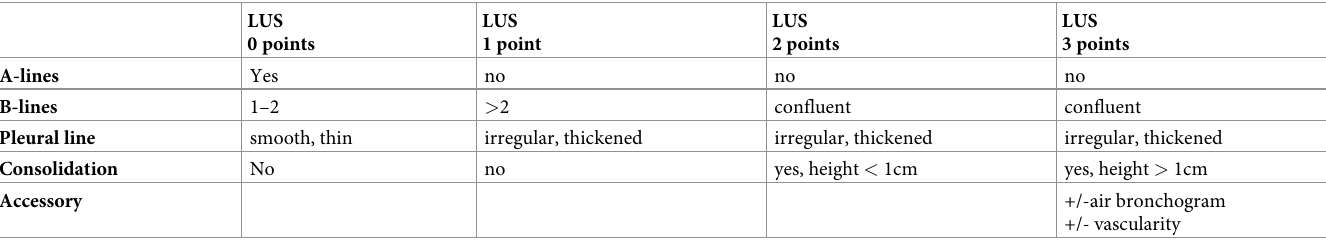
Table 1. Lung ultrasound score according to CLUE protocol